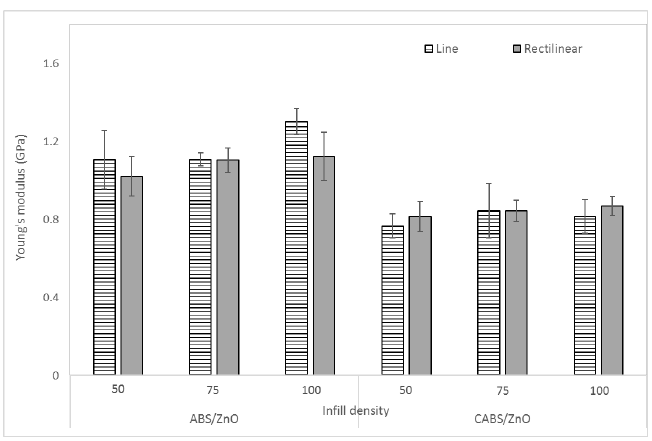
Figure 5. Effect of infill density and printing pattern on Young’s modulus of ABS/ZnO and CABS/ZnO samples.